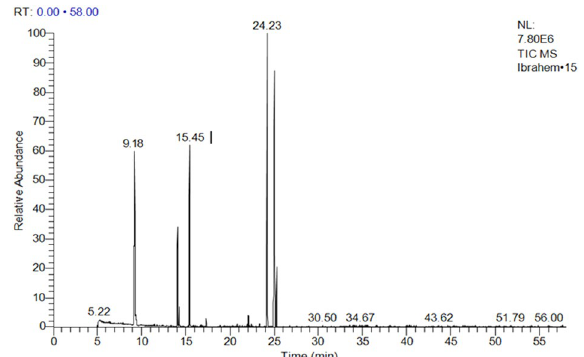
Figure 2. GC/MS analysis of the Anethum graveolens L.